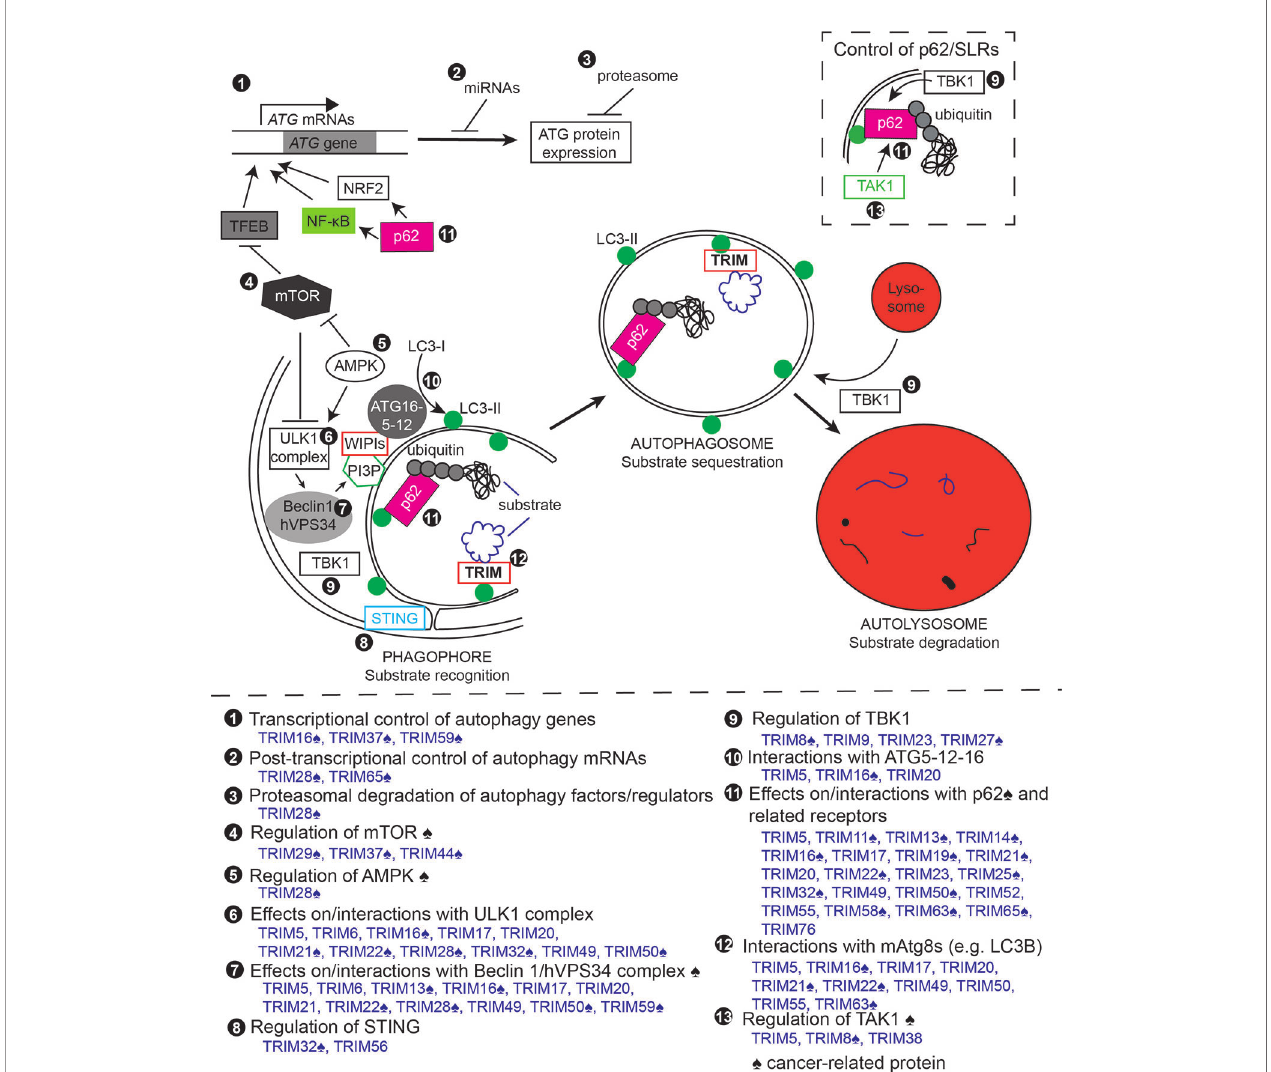
FIGURE 2 | Tripartite motif-containing protein family members (TRIMs) regulate the autophagy pathway at multiple points. Top, schematic of different steps/stages of the autophagy pathway. Circled numbers indicate steps of the autophagy pathway or autophagy regulators and factors that are impacted by individual TRIMs. Bottom, summary of TRIM actions in autophagy. Circled numbers correspond with those on the schematic. ♠ symbol indicates proteins with reported cancer